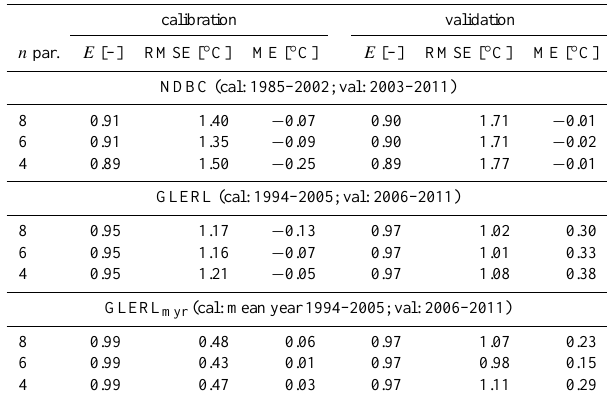
Table 3. Efficiency index ( E ), root-mean-square error (RMSE) and mean error (ME) during calibration and validation periods (NDBC, GLERL and GLERL myr